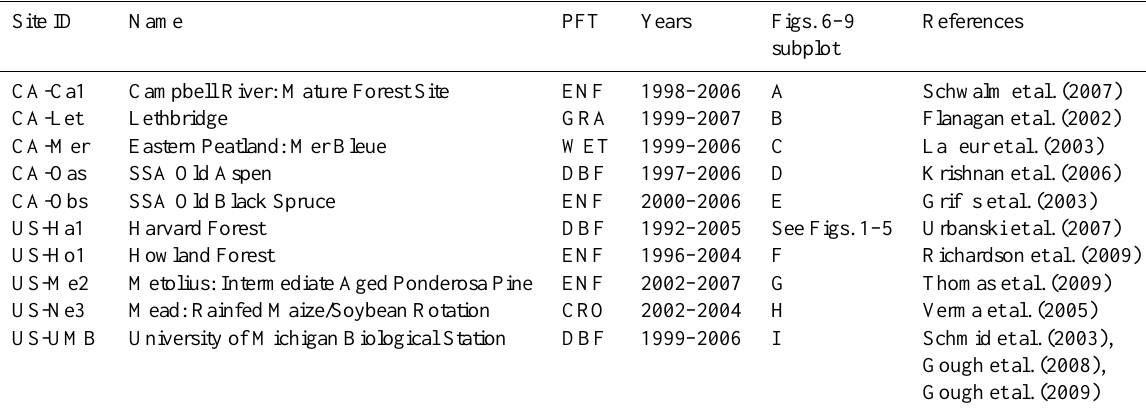
Table 1. Measurement sites of the North American Carbon Program Site-Level Interim Synthesis investigated by Dietze et al. (2011) and explored in the present analysis. CRO: crop; DBF: deciduous broadleaf forest; ENF: evergreen needleleaf forest; GRA: grassland; PFT: plant functional type; WET: wetland.